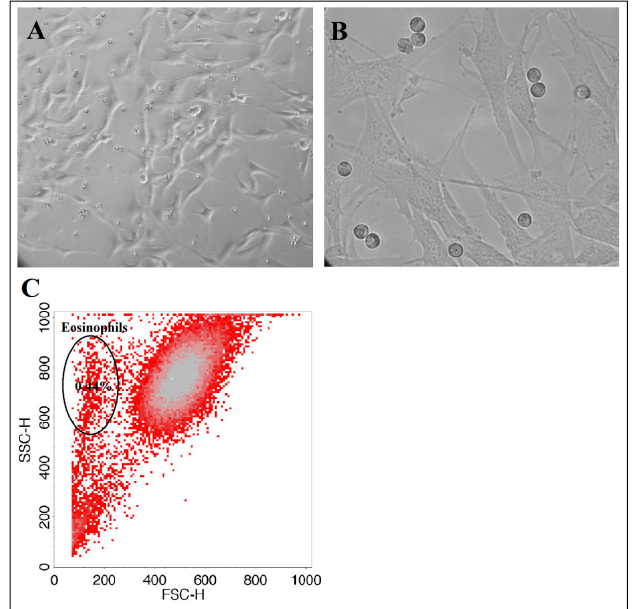
Figure 3. Combined cell cultures between eosinophils and ASM cells. ( A ) the picture at 10× objective. ( B ) the picture at 40× objective. ( C ) remaining eosinophil number after combined cell culture separation. Collected cell number—1 × 10 5 . Eosinophil number is expressed from total collected cell count, rejecting cell debris.